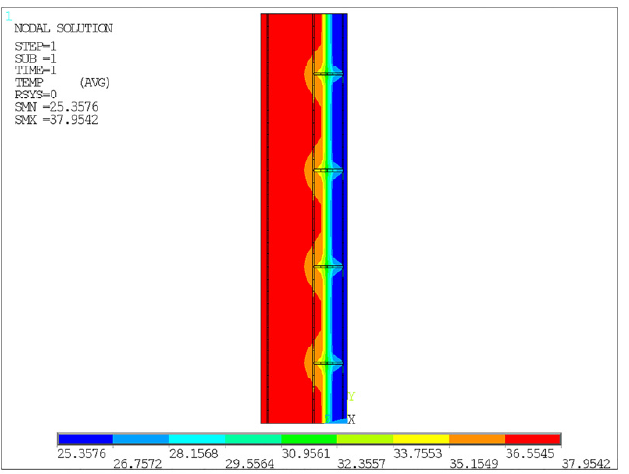
Figure 16. S-Rebar heat flux vector diagram.